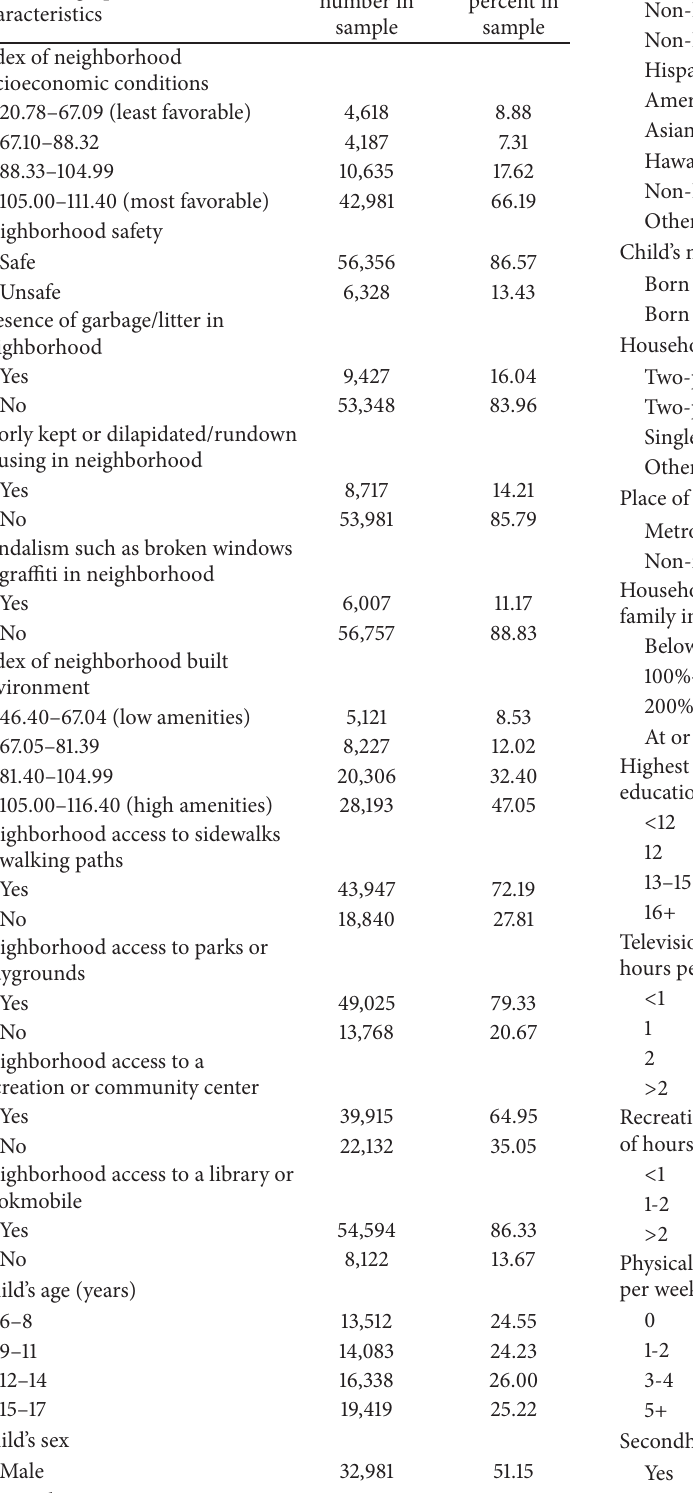
Table 2: Descriptive statistics of the sample for children aged 6–17 years, according to neighborhood, sociodemographic, and behavioral characteristics: the 2007 National Survey of Children’s Health ( 𝑁 = 63,352).